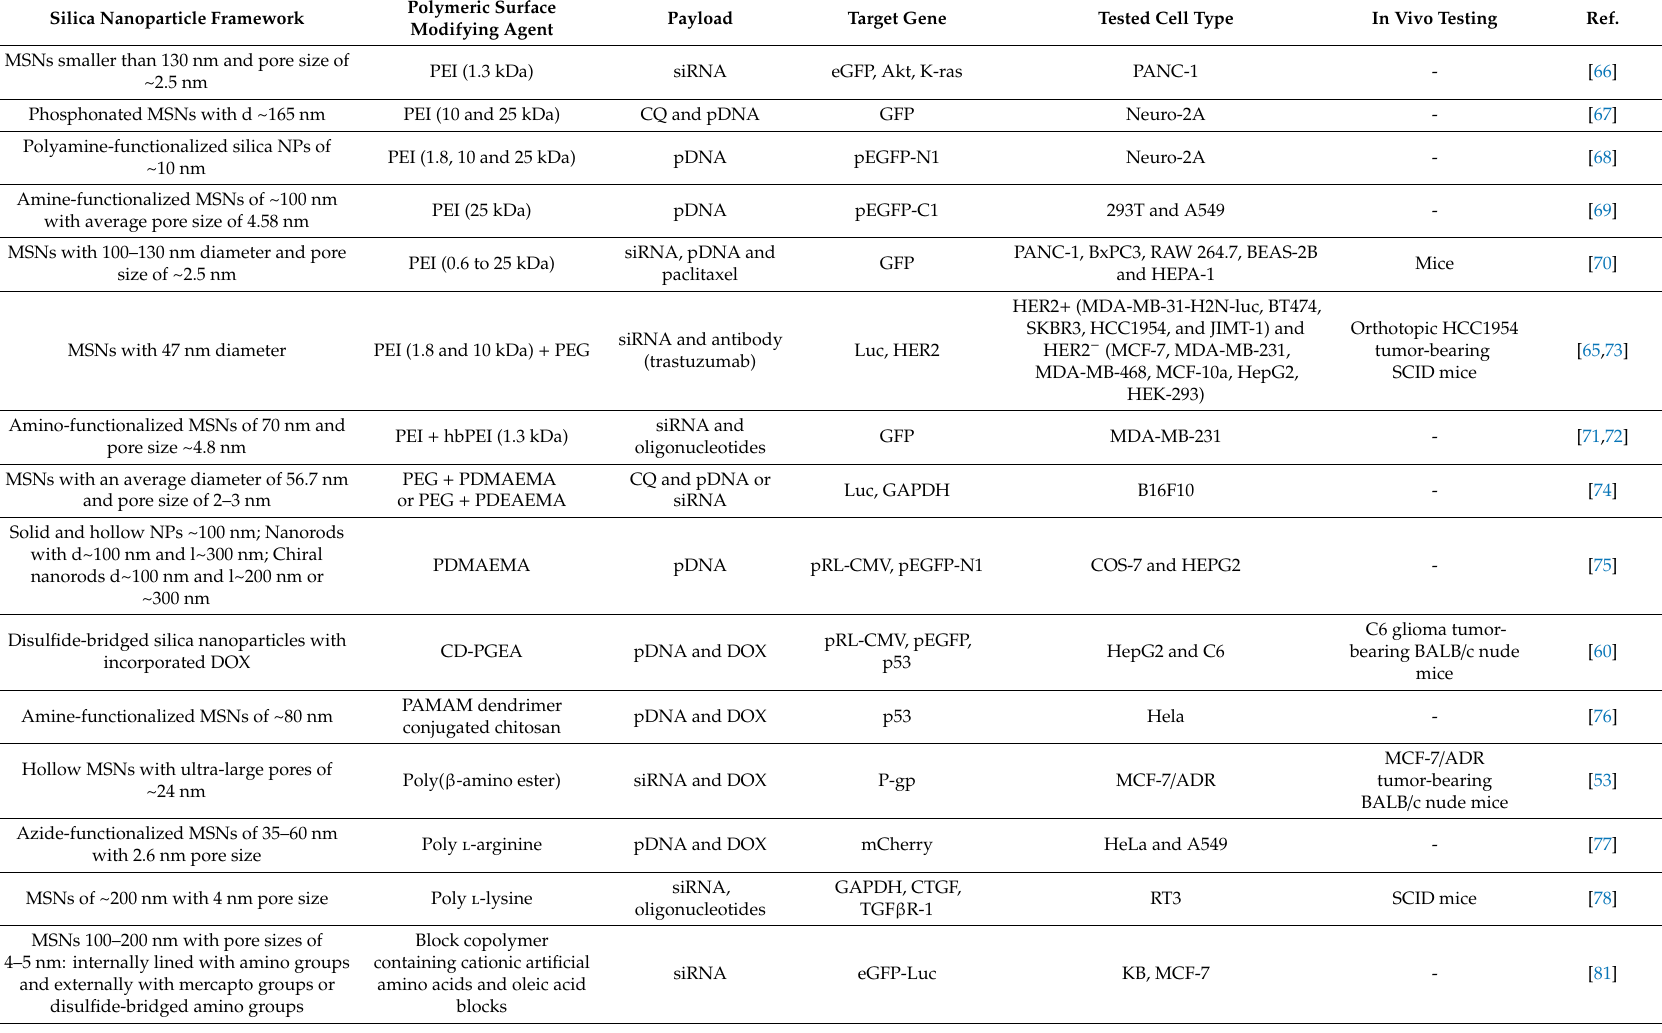
Table 3. Examples of gene delivery systems based on polymer-modified silica